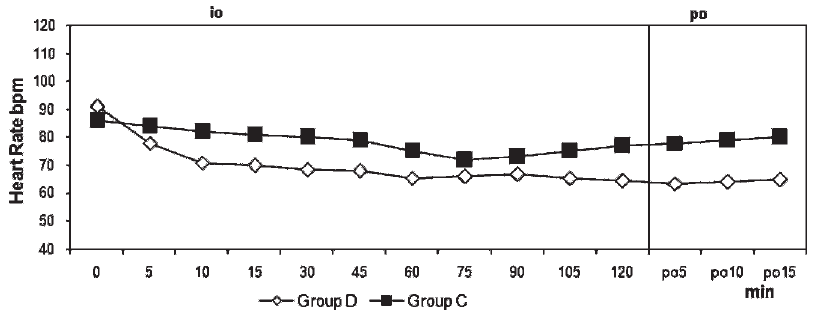
Figure 3 - Heart Rates. io: intraoperative, po: postoperative, min; minute, Intraoperative and postoperative heart rate. + p , 0.05 when two groups are compared, * p , 0.05 compared with baseline